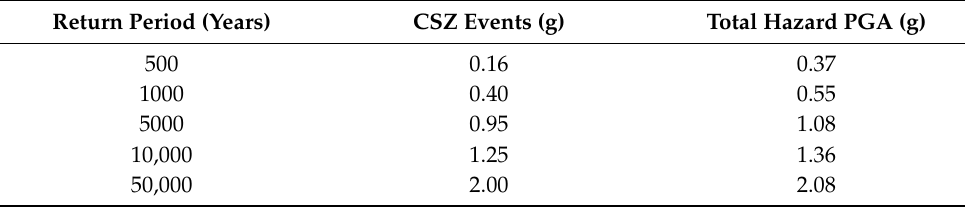
Table 1. Probabilistic seismic hazards at the Scoggins Dam Site. Return Period (Years) CSZ Events (g) Total Hazard PGA (g)